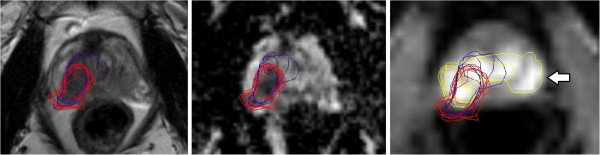
(Patient No.1). Transversal slices through the middle prostate gland; left = T2w-, middle = DWI-, right = DCE-sequence. Left and middle picture show T2w (violet contour) and DWI (red contour) based GTV-delineation respectively. On the right image additionally DCE (yellow contour) based GTV-delineation; the arrow indicates delineation of non-specific enhancement by two observers in the left gland symmetric to the right side.